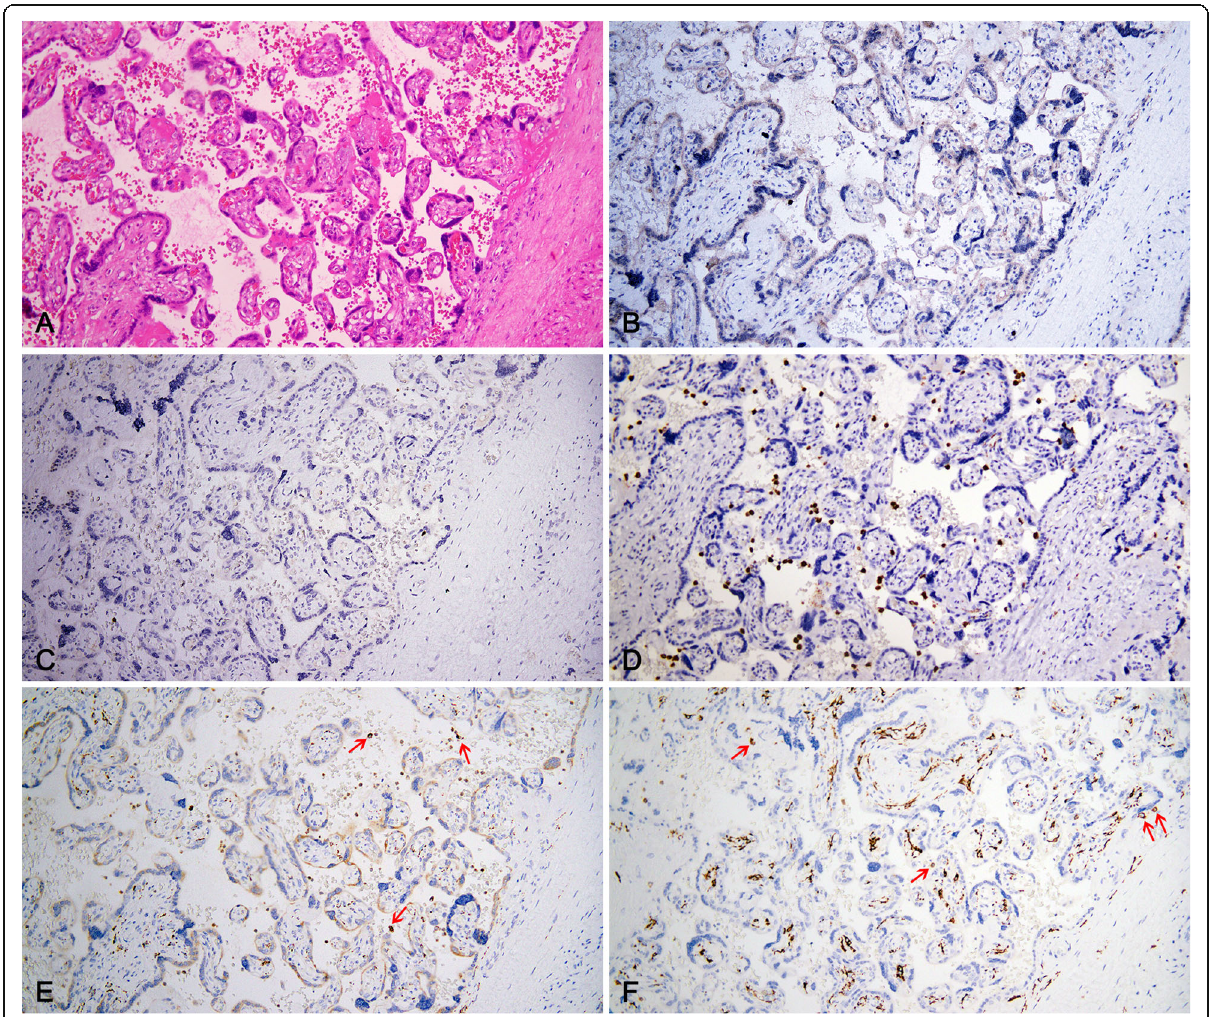
Fig. 2 H&E and Immunohistochemical staining of inflammatory cells and Hofbauer cells of case 8. a , mild acute intervillositis was presented, the inflammatory infiltration is foci-like and consists of several neutrophils, no trophoblast necrosis and prominent perivillous fibrin deposition was found in the intervillous space. b and c CD3 ( b ) and CD20 ( c ) staining revealed only occasional infiltration of T lymphocytes and B lymphocytes in the middle of terminal villi (Envision, Original magnifications × 200). d, CD15 staining revealed several neutrophils in the intervillous space. e and f, CD68 ( e ) and CD163 ( f ) revealed scanty histiocytes in the intervillous space (red arrows) and none prominently increased numbers of Hofbauer cells present in the stroma of all villi (Envision, original magnifications ×